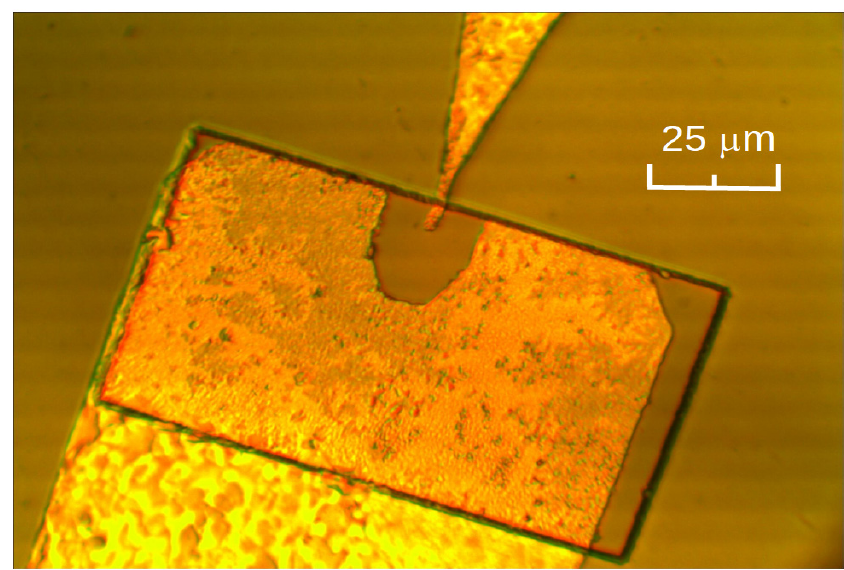
Figure 2. Micrograph of the planar microwave diode on semi-insulating GaAs.